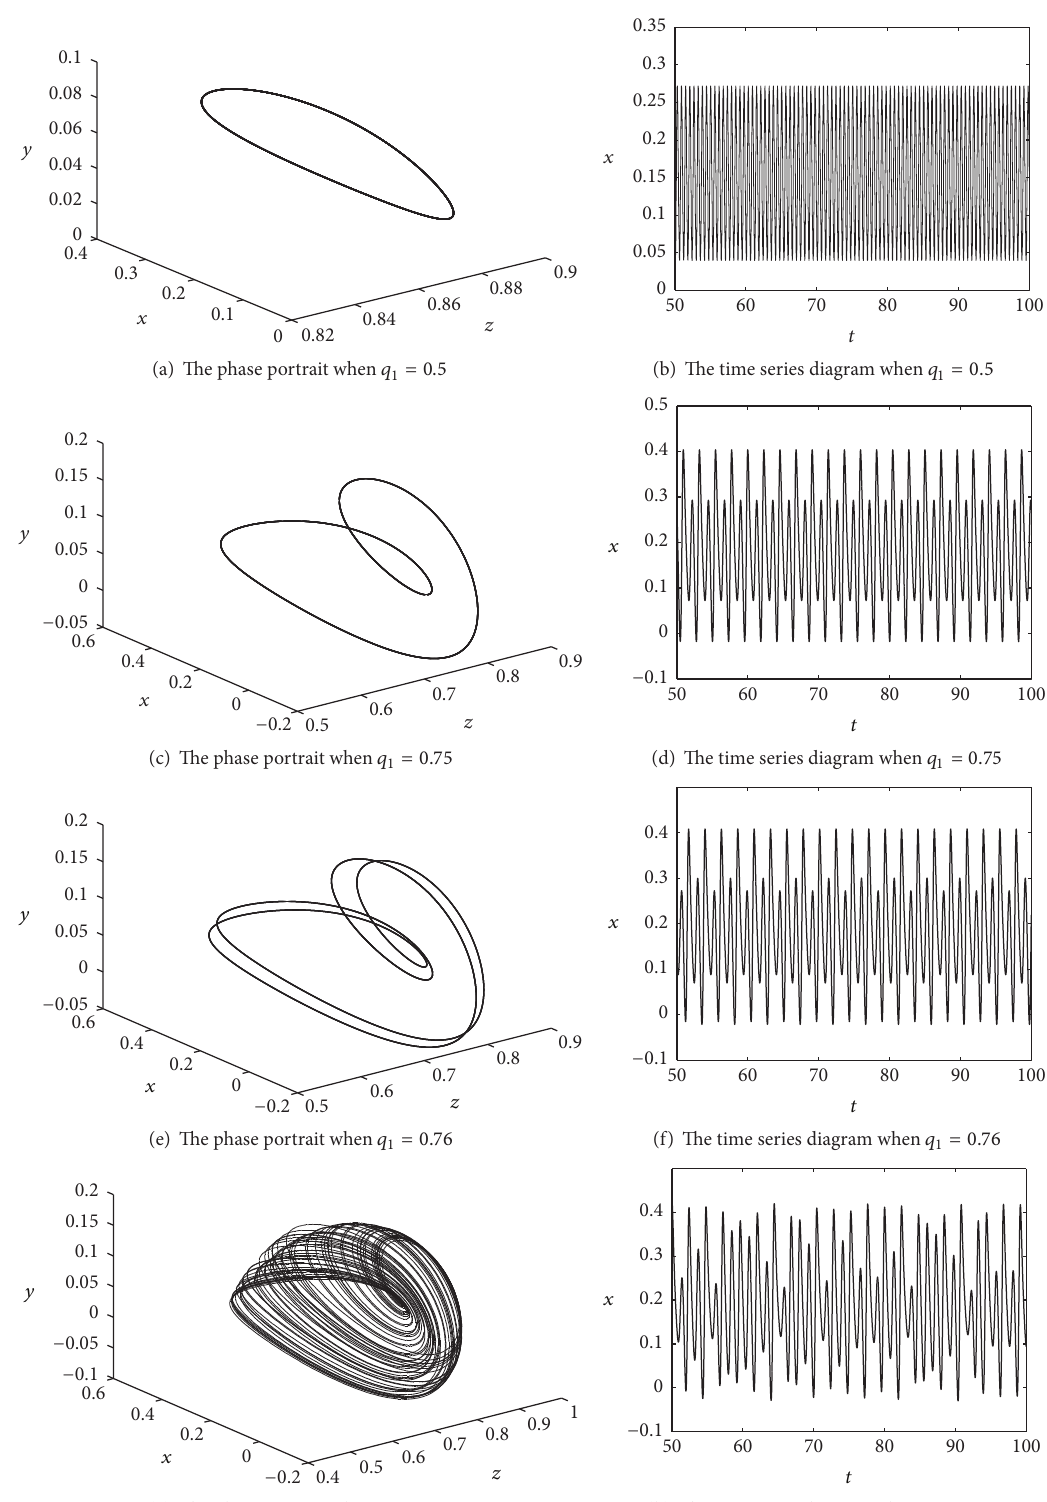
Figure 3: The phase portraits and time series diagrams of system (2) with different values of the order 𝑞 1